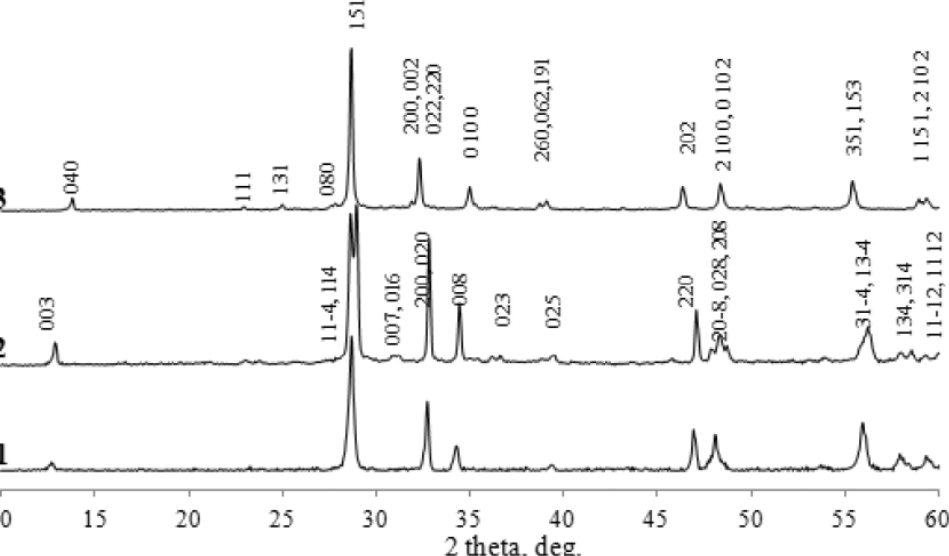
Fig. 1. X-ray patterns of Bi Fe O 0.12 9- 